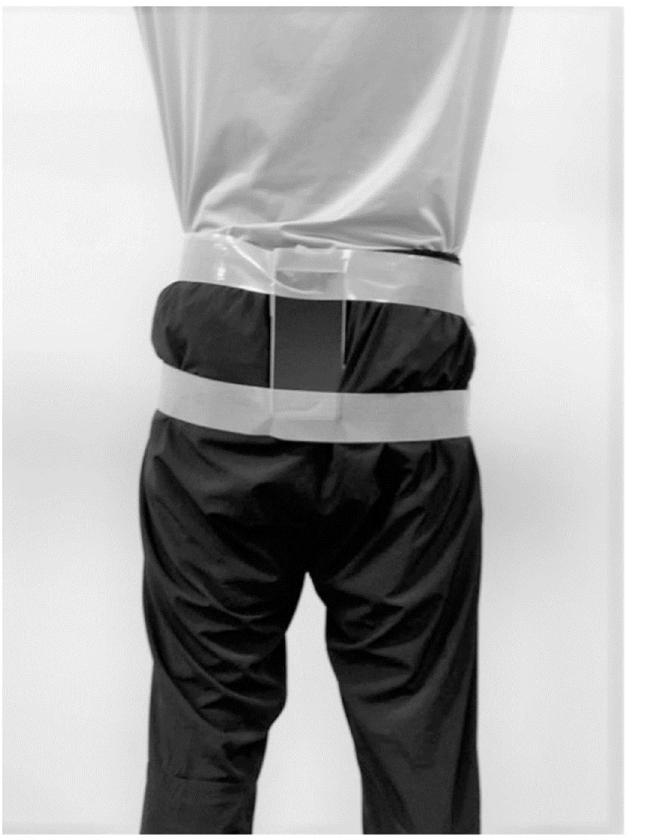
Fig 2. Smartphone attached to the